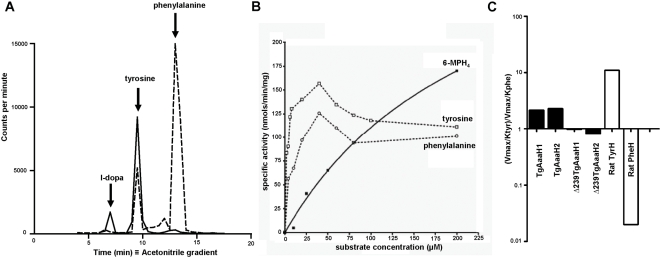
TgAaaH 1&2 encode tyrosine hydroxylase with unusual substrate specificity.A HPLC tracing of production of tyrosine and l-DOPA by the recombinant enzymes. Fractions were collected and radiolabel monitored by scintillation counting. Internal markers of phenylalanine, tyrosine, and l-DOPA are marked by arrows. B Graph showing the catalysis of tyrosine and phenylalanine in relation to substrate concentration. The substrates are tyrosine (0–200 µM) and phenylalanine (0–200 µM). The dependency on the tetrahydrobiopterin analog 6-MPH4 over a range of concentrations is also shown with tyrosine (50 µM) as substrate. C Relative catalysis of tyrosine and phenylalanine reveal substrate preference. Reaction rates and KM of the substrates were measured and the ratios are shown. A ratio of 1 indicates no substrate specificity. A ratio of less than 1 indicates a preference for phenylalanine as substrate; demonstrated by the inclusion of the rat phenylalanine hydroxylase (20). A ratio of greater than 1 indicates a preference for tyrosine as demonstrated by the inclusion of rat tyrosine hydroxylase.